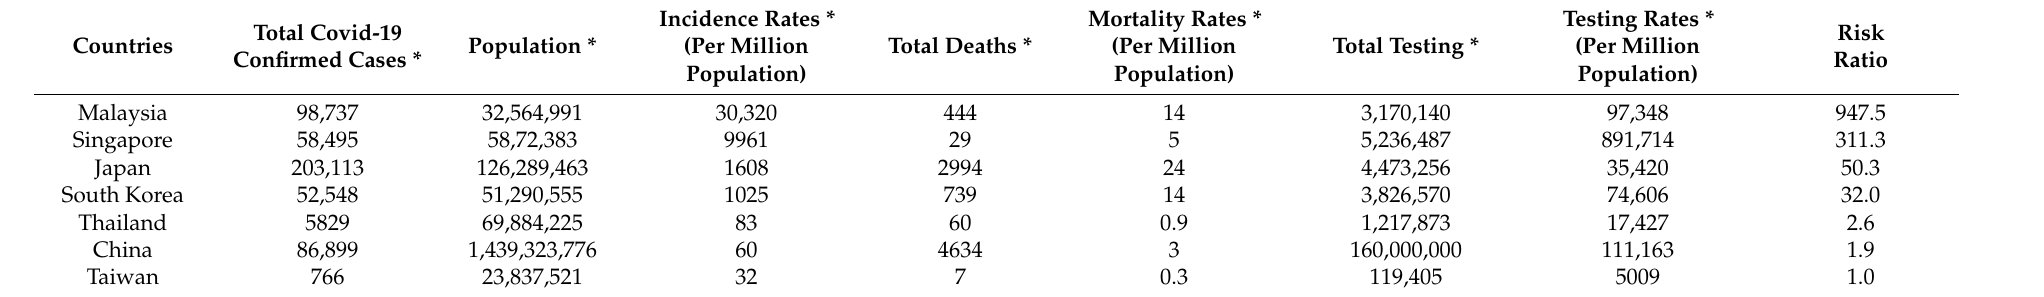
Table 2. COVID-19 incidence, mortality, and testing rates of Taiwan and neighboring countries, with risk ratios of neighboring